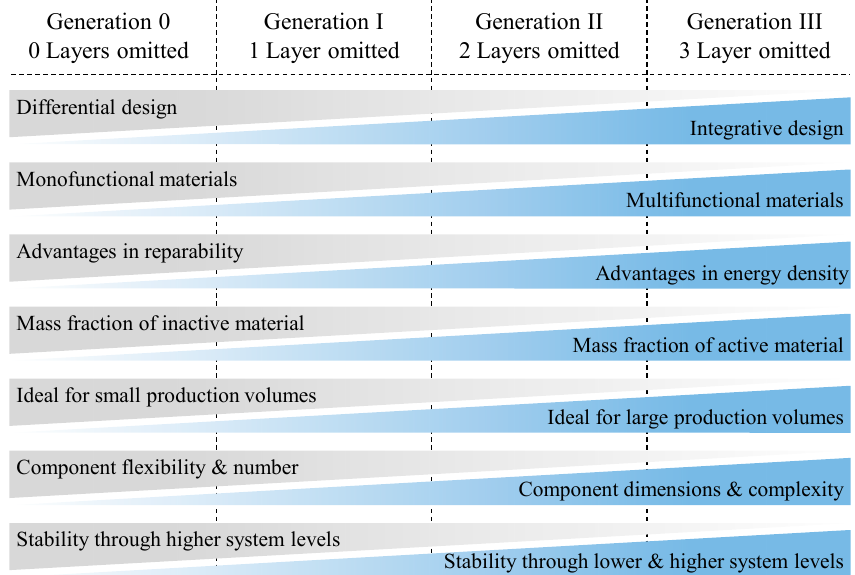
Figure 5. Derived implications for the distinguished ba tt ery system architectures.